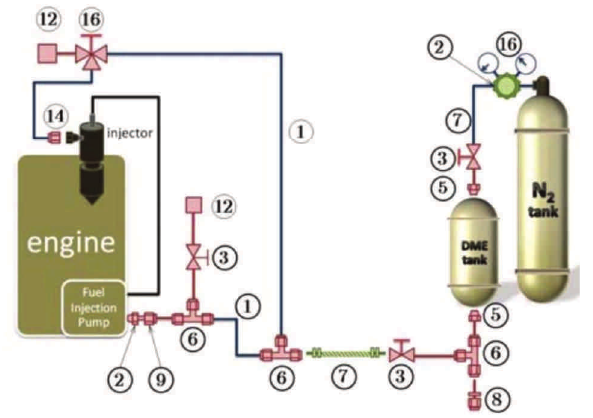
Fig. 1. High pressure direct injection engine test stand 1 – flexible Teflon hose tube adapter, 2 – male connector, 3 – ball valve, 5 – tube adapter, 7 –